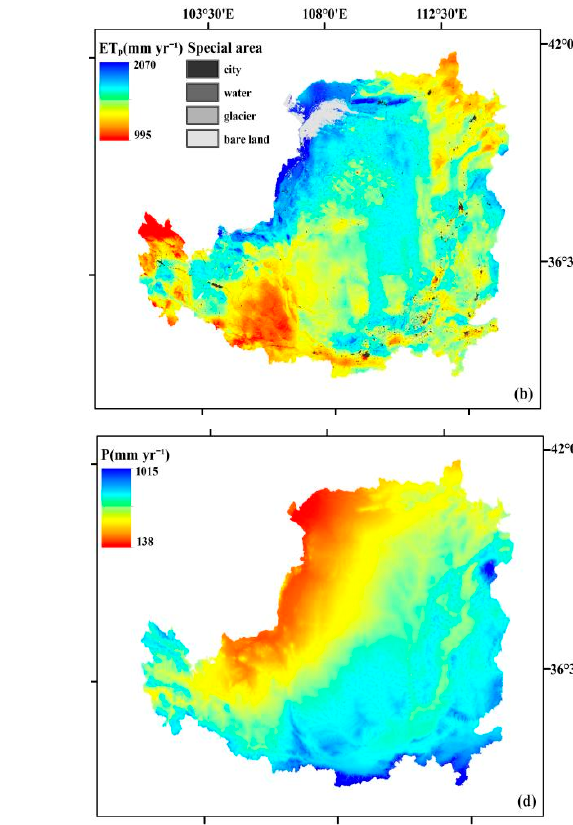
7 of 17 Figure 2. Technology roadmap. 3. Results and Analysis 3.1. Spatial Patterns of ET a , ET ₚ , NDVI, and Precipitation With certain vegetation and climate conditions in the Loess Plateau, precipitation and available energy which is represented by ET ₚ are the main driving factors of long-term annual ET a [39]. As shown in Figure 3a, there was a large spatial variability for annual ET a on the LP, which gradually increased from northwest to southeast areas, ranging from 139 mm to 936 mm. Compared with the spatial distribution of annual precipitation as shown in Figure 3d, the spatial pattern of ET a was consistent with it on the whole. Multi-year averaged ET a (370 mm) shared about 80% of the corresponding precipitation (466 mm). This result made clear that evaporation was the way for most of the precipitation to return to the atmosphere eventually and that precipitation on the multi-year scale mostly regu-